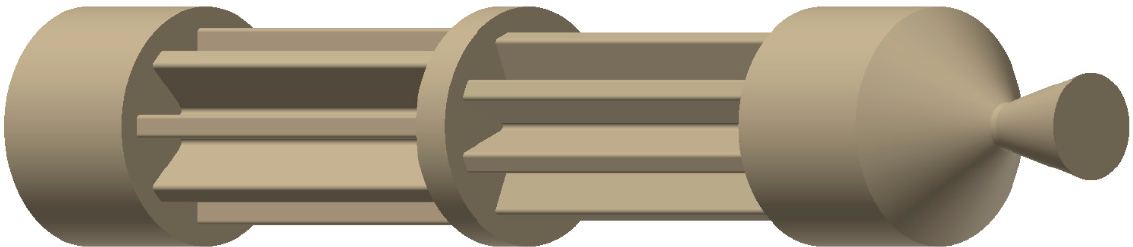
Figure 4. Domain of flow field of the motor with star-segmented rotation grain.